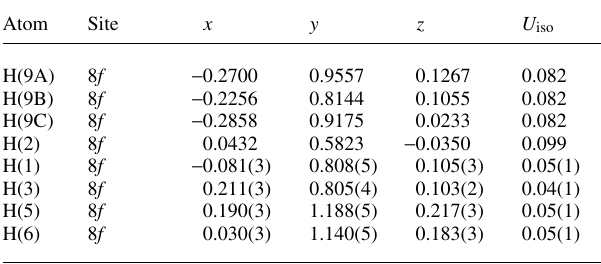
Table 2. Atomic coordinates and displacement parameters (in Å 2 )